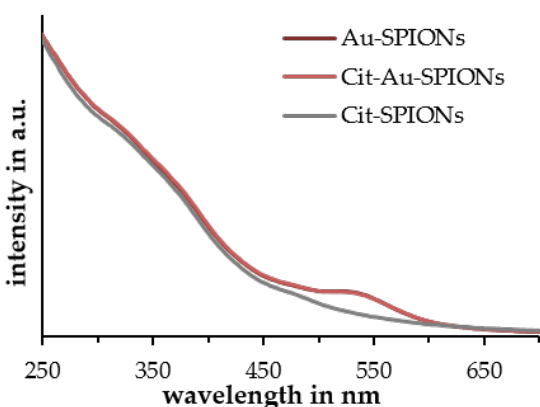
Figure A1. UV–Vis measurements of Cit-SPIONs, Au-SPIONs and Cit-Au-SPIONs showing an intensity peak at a wavelength of 520 nm for both gold-coated SPION independent of additional citrate-stabilization.